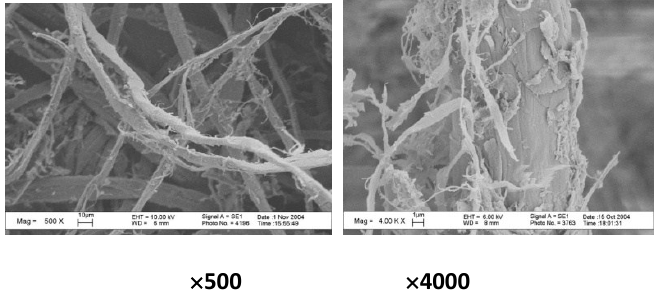
Figure 3. Morphology of fibrillated fibers.